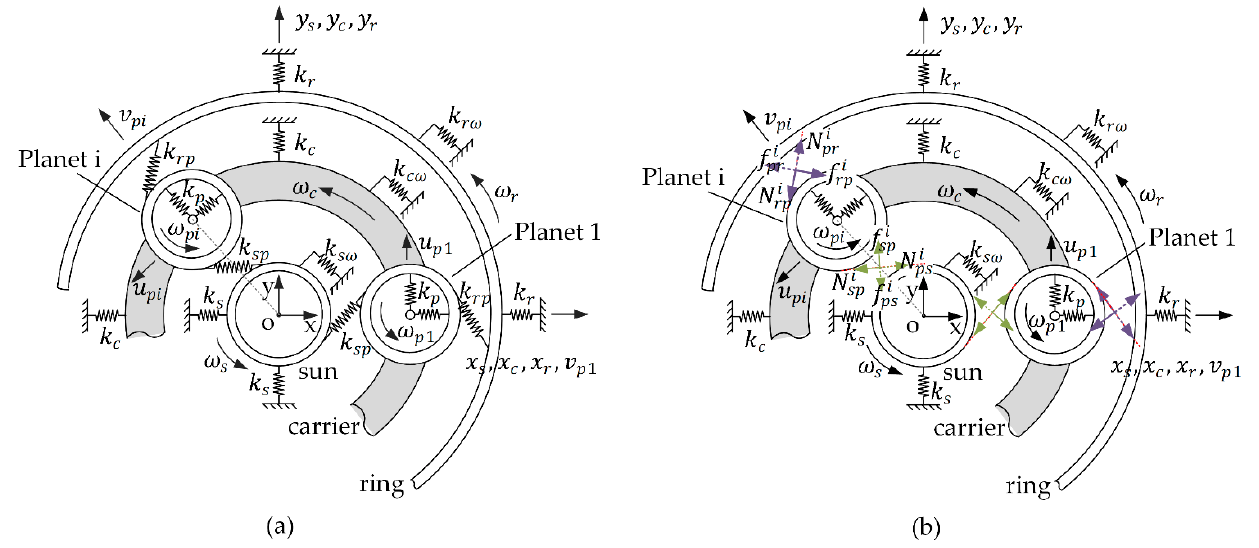
Figure 1. LTC modeling of a planetary gear set: ( a ) using the existing method ( b ) using the proposed method.